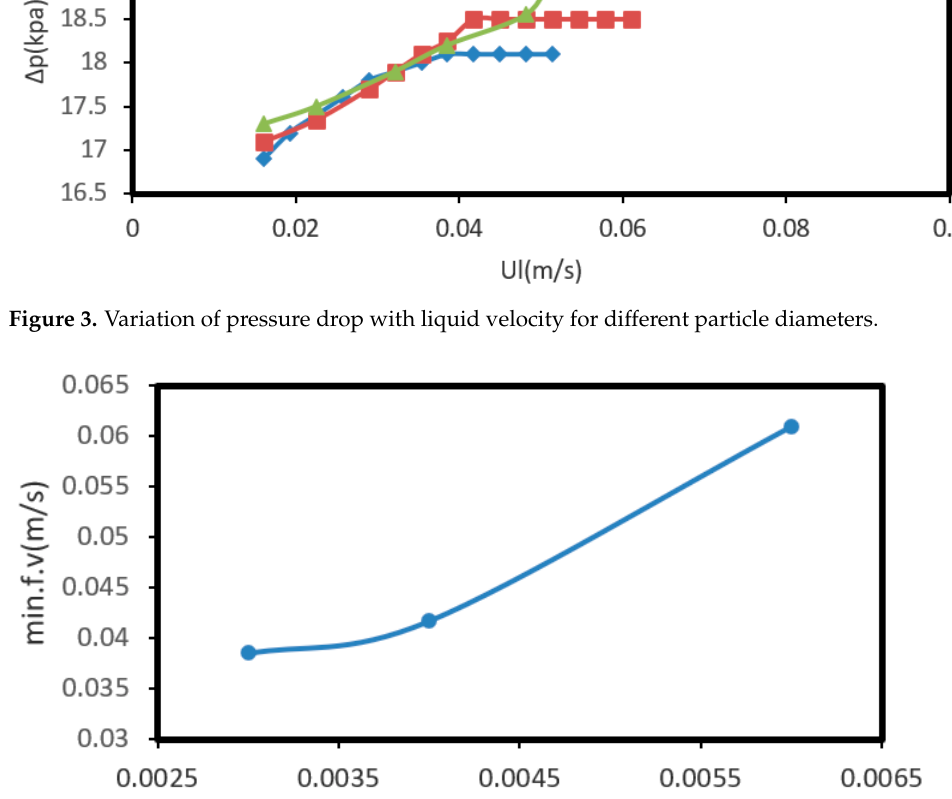
Figure 3. Variation of pressure drop with liquid velocity for different particle diameters.